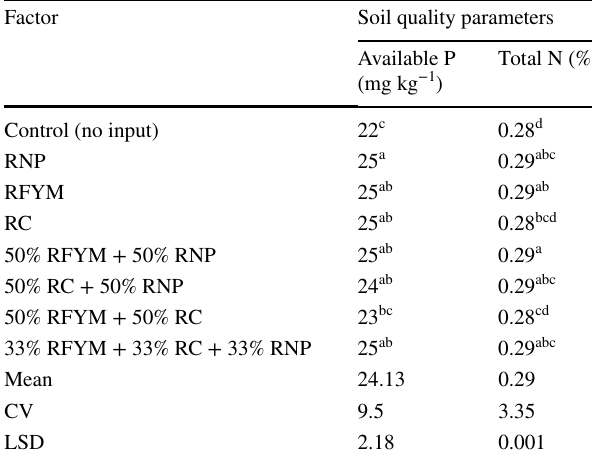
Table 4 Mean soil chemical properties as influenced by combined application of organic and mineral amendments after harvesting of malting barley at Lemu-Bilbilo district in southeastern Ethiopian